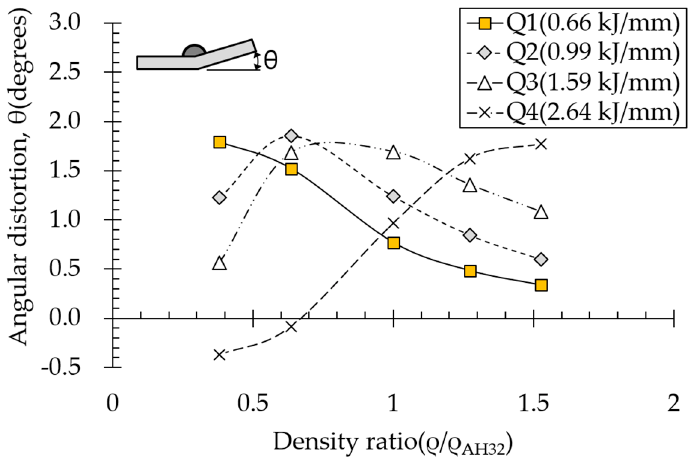
ff ect of density on angular Figure 11. Effect of density on angular distortion. Figure 11. E Figure 11. Effect of density on angular distortion.